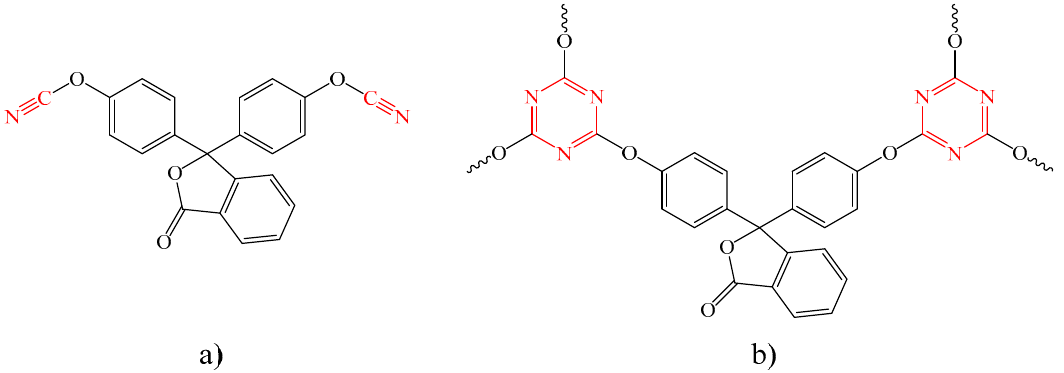
Figure 16. Chemical structures of ( a ) phenolphthalein dicyanate (DCFT), and ( b ) cyanurate ester resin (DCFT-Resin).